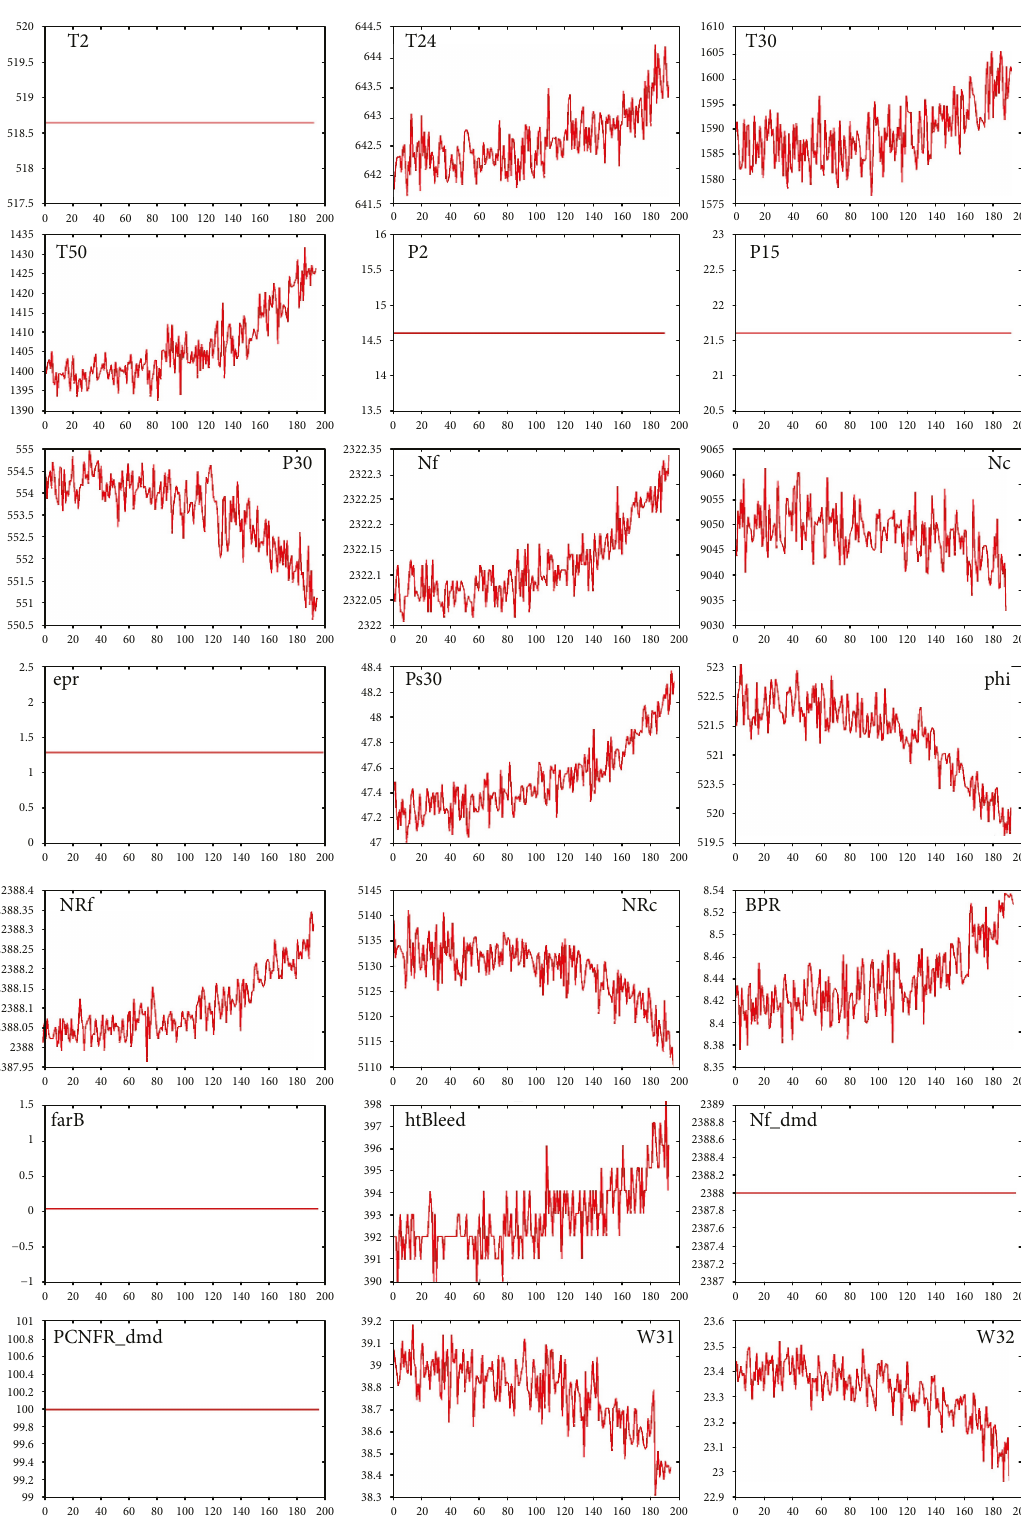
Figure 9: Engine degradation tendencies using the data from di ff erent sensors over